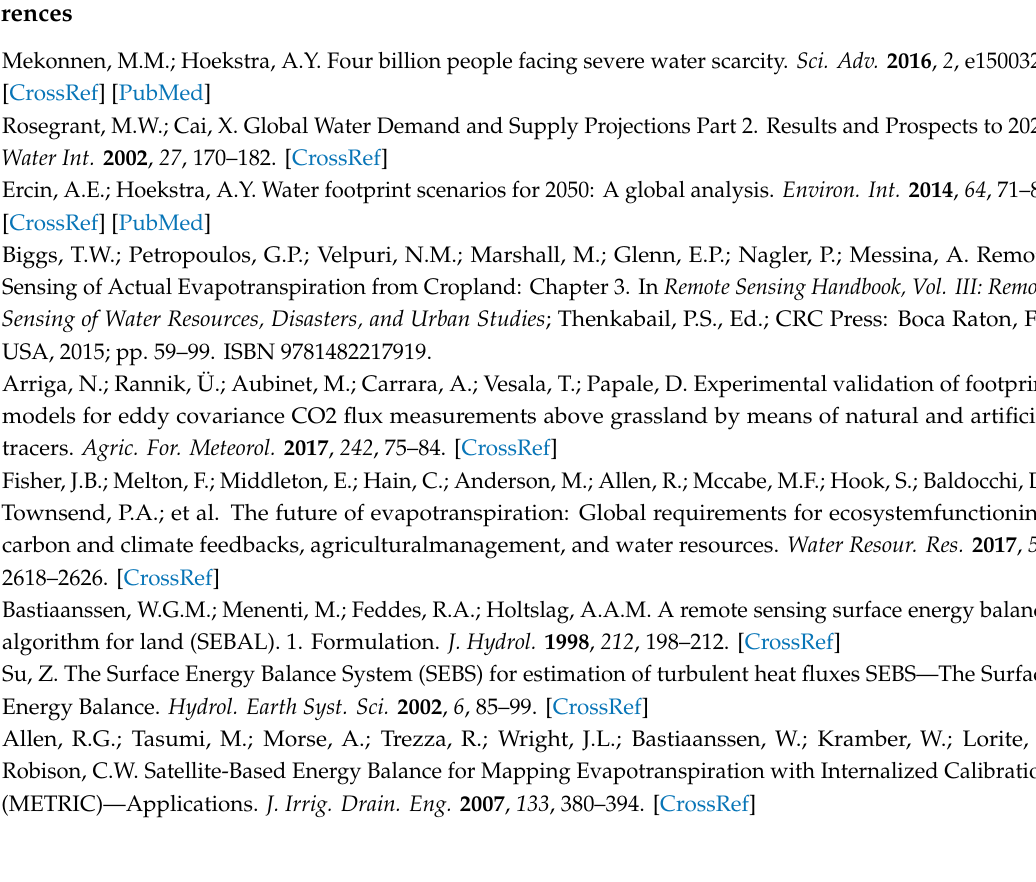
Figure S1: Comparison of measured and estimated LAI from 2009 to 2014 over irrigated cropland (rice cultivated in a flooding system). The grey boxes represent the average LAI MODIS inter-quartile range (IQR), the black tick lines represent the median and the whiskers indicate variability outside the upper and lower quartiles. Experimental LAI measurements for each growing season were interpolated to obtain values in the same time interval of MODIS. The red dots represent the mean of three LAI growing season measurements and the red line represents the fitted curve of measured LAI after planting. Table S1: Validation of MERRA reanalysis data against measured environmental variables: net radiation ( R n ), global radiation ( R g ), air temperature ( Temp ) and vapor pressure deficit (VPD), used as MOD16 algorithm inputs for 2004–2005 at the PRS site. Table S2: Validation of MERRA reanalysis data against measured environmental variables: net radiation ( R n ), global radiation ( R g ), air temperature ( Temp ) and vapor pressure deficit (VPD), used as MOD16 algorithm inputs for 2011–2014 at the CAS